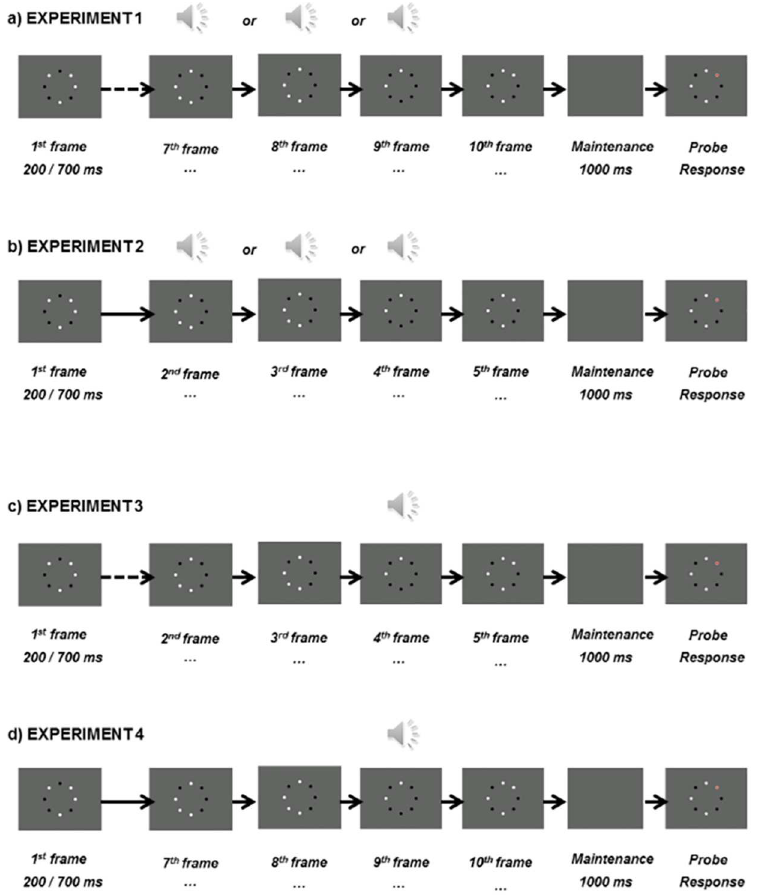
Fig 1. Schematic representation of the procedures in Experiments 1–4. Panels a) to d) correspondto each of Experiments 1 to